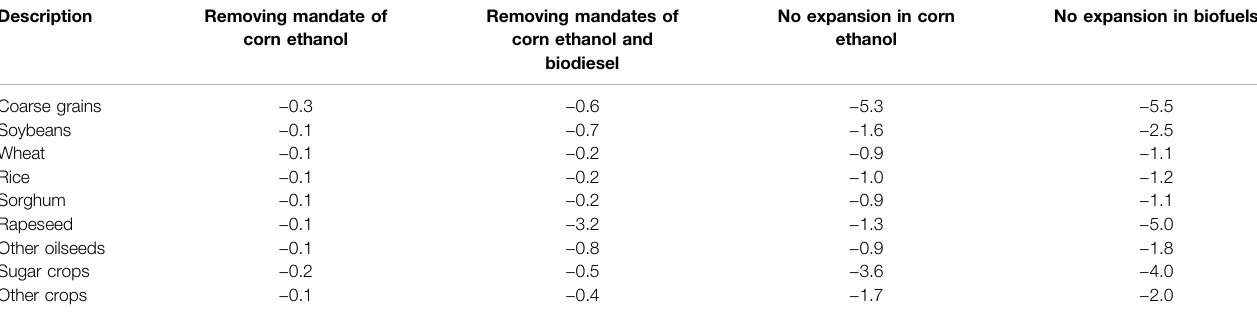
TABLE 2 | Percentage change in real commodity prices under alternative counterfactual experiments for 2004 – 2011.